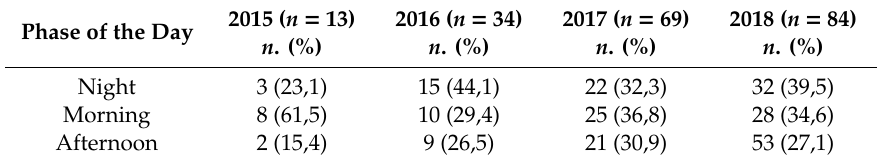
Table 5. Distribution (%) of Incident Reporting records, by phase of the day and the reporting